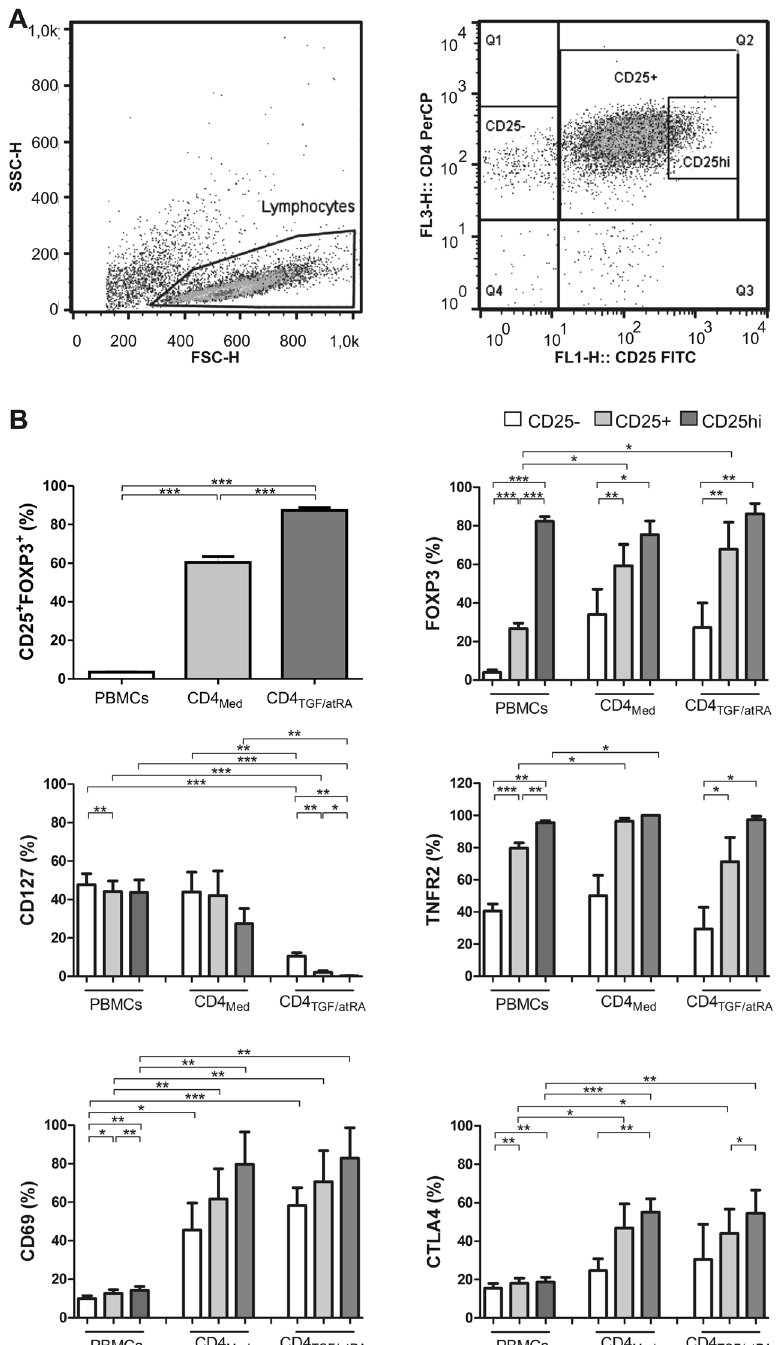
Figure 2. Immunophenotypic characterization of cells generated in CD4 TGF/atRA and CD4 Med conditions. UCB CD4 + CD25 − CD45RA + naïve T-cells were activated with anti-CD2/CD3/CD28 beads and cultured for 5 days in the presence of 5 ng/ml TGF- β , 50 U/ml IL-2 and 100 nM atRA (CD4 TGF/atRA ), or in the presence of 50 U/ml IL-2 alone (CD4 Med ). Next, percentage of FOXP3 + , CD127 − , TNFR2 + , CD69 + and CTLA4 + cells were determined in subpopulations based on the expression of CD25. ( A ) Representative gating strategy used to define the subpopulations analyzed (derived from an experiment in the CD4 Med condition). Lymphocytes were gated using FSC and SSC parameters and percentage of positive cells for each markers were determined in CD25 − , CD25 + and CD25 hi (as defined by the top 2% of the CD25 + cells) subpopulations of CD4 + cells. ( B ) Graphs depicting the results obtained from cells derived from three or more independent experiments (each using distinct donor samples). For comparisons, the same subpopulations were evaluated in the peripheral blood of five distinct normal control donors. Bars indicate mean and SEM. The statistical test used to compare subpopulations of the same culture condition (or PBMC) was a paired T-test, while the comparison between similar subpopulations of distinct conditions was a non-paired T-test. * p < 0.05, ** p < 0.01, *** p <